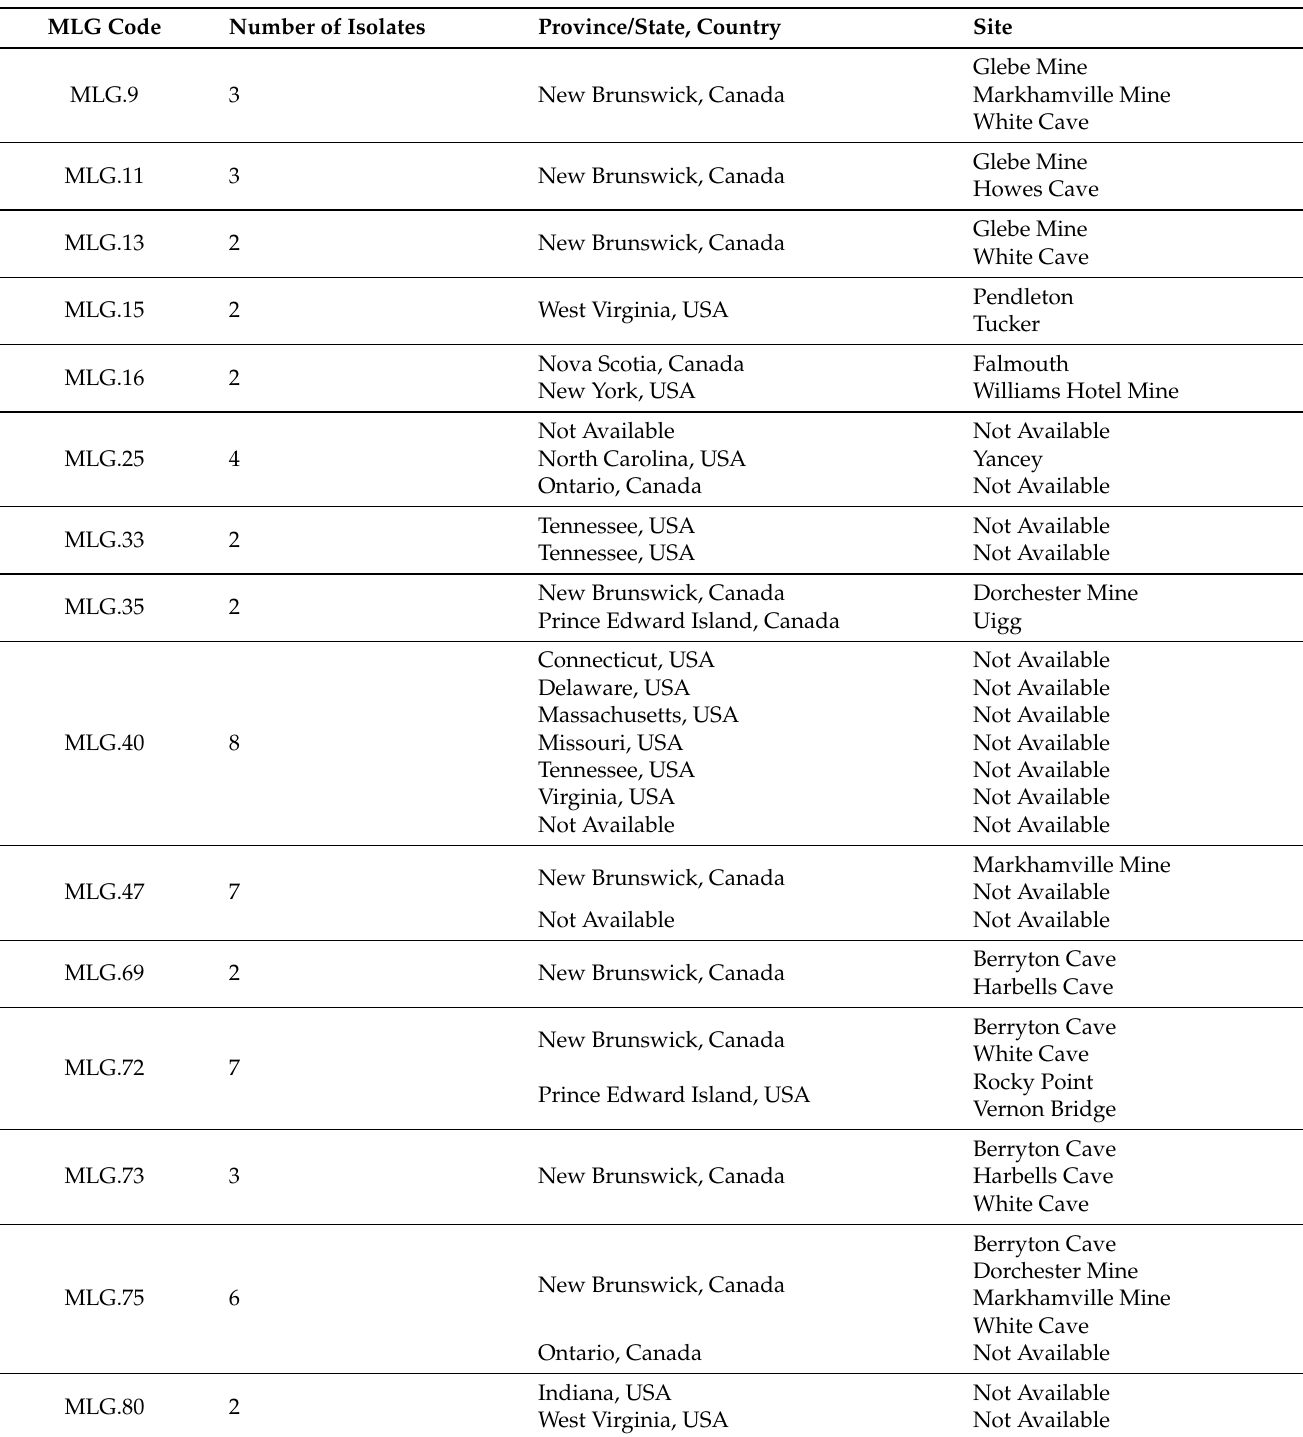
Table 1. Shared microsatellite genotypes present in multiple caves across North America. The isolates reported here for each genotype have been clone-corrected to exclude clonal individuals from the same sampling